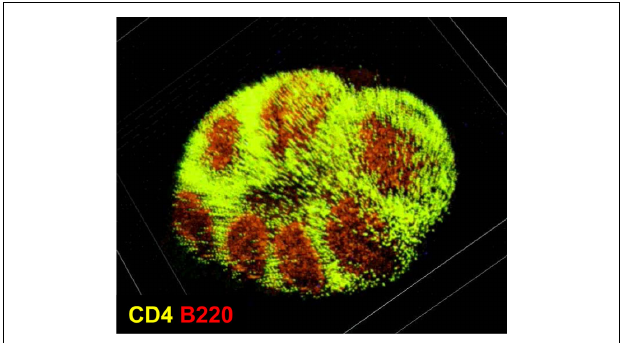
FIGURE 1 | Microarchitecture of murine Peyer’s patches. PurifiedT cells (green) and B cells (red) were chemically labeled with carboxyfluorescein succinimidyl ester and carboxy-SNARF-1, respectively, and adoptively transferred into mice. Fifteen hours after the transfer, cell distribution in the Peyer’s patches was observed at the whole-tissue level by using macro-confocal